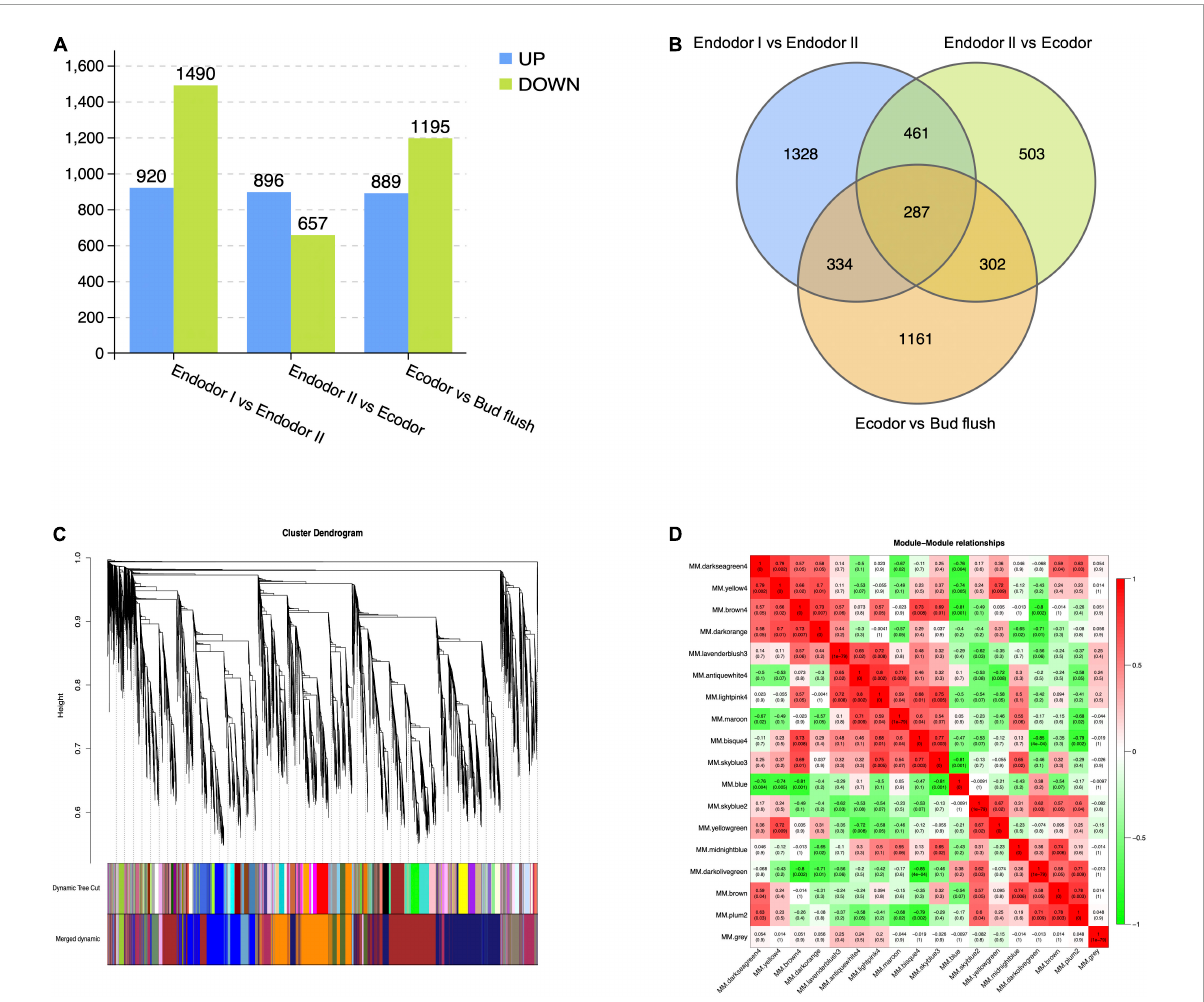
FIGURE2 The identification of differentially expressed genes and co-expressed gene modules from WGCNA analysis. (A) The number of up-regulated or down-regulated DEGs among stage comparisons (Endodor I vs. Endodor II, Endodor II vs. Ecodor, and Ecodor-vs.-Bud flush). (B) Venn diagram of DEGs identified across stage comparisons (Endodor I vs. Endodor II, Endodor II vs. Ecodor, and Ecodor-vs.-Bud flush). (C) Hierarchical clustering dendrogram showing 17 co-expressed gene modules in designated colors from WGCNA analysis. (D) Heatmaps showing Pearson correlation among eigengenes of co-expressed gene modules. The Pearson correlation coefficients was colored according to the